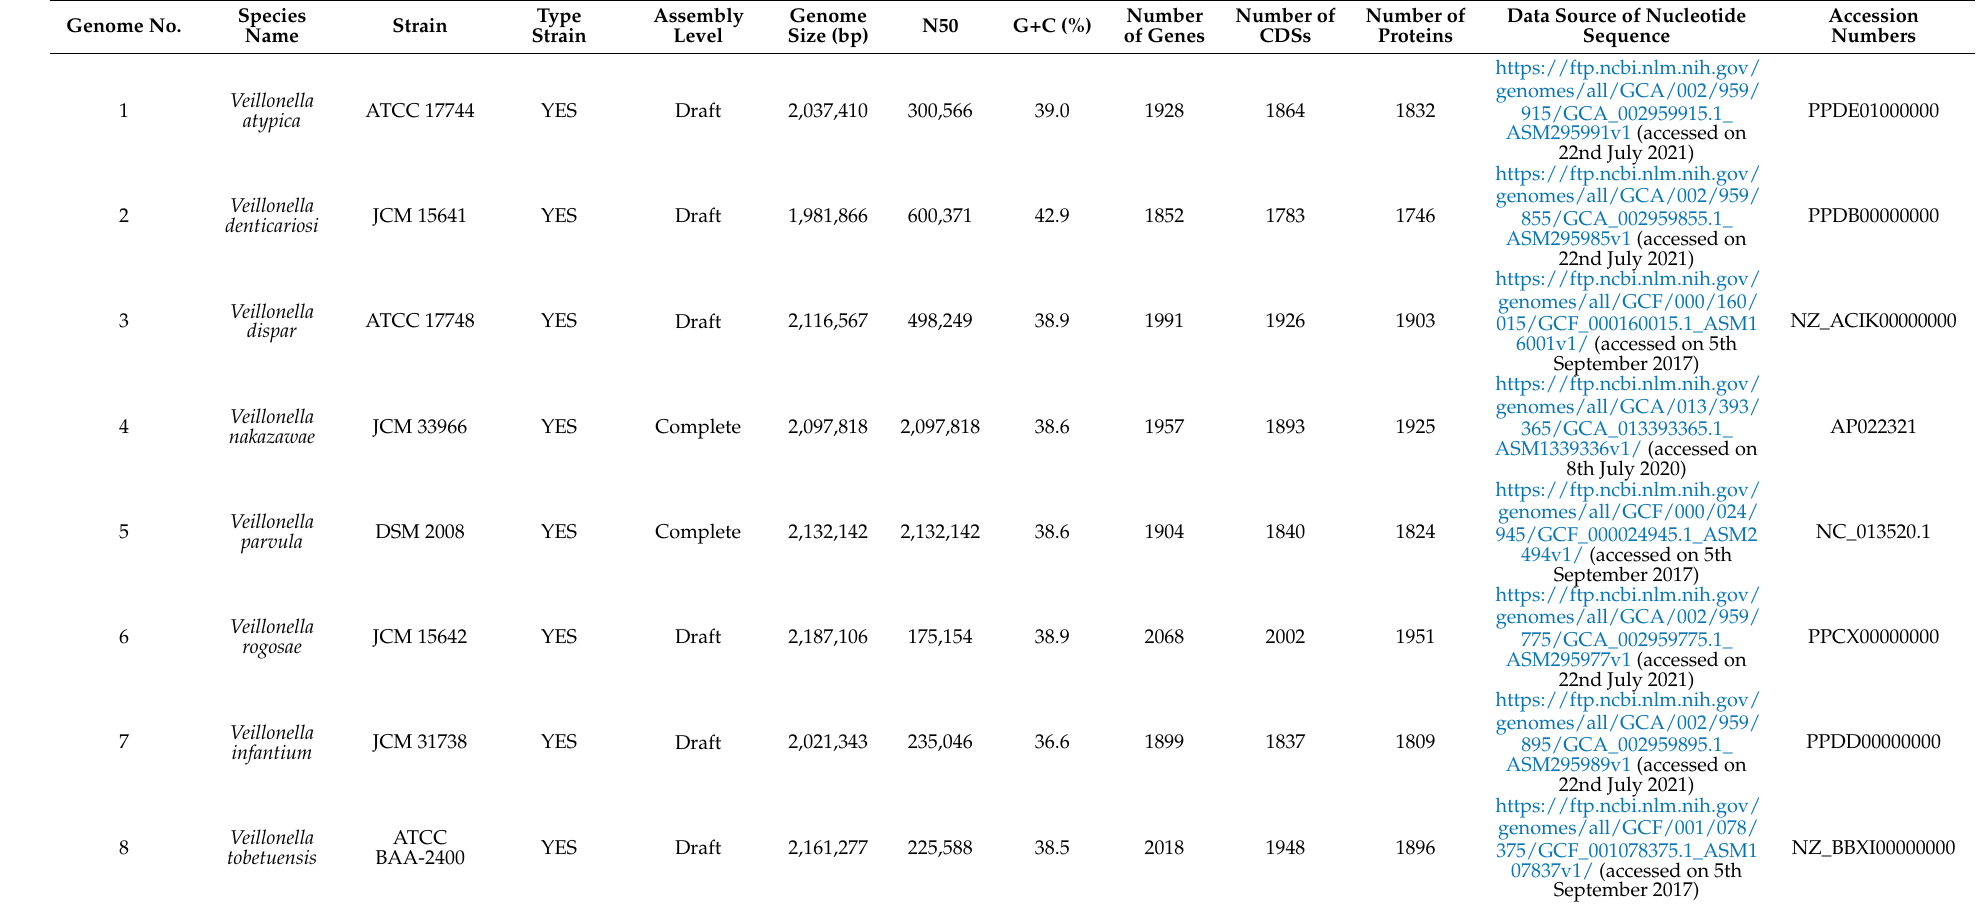
Table 1. The genome information assembled in this study. The protein sequences of the four Veillonella strains, V. dispar , V. nakazawae , V. parvula and V. tobetsuensis were collected from National Center for Biotechnology Information. The others were assembled in this study. Genome